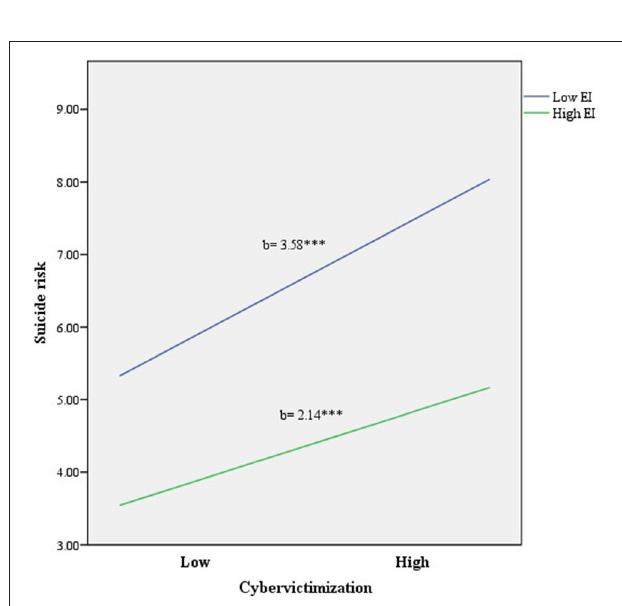
FIGURE 2 | Relationship of cybervictimization and EI for predicting suicide risk, *** p <